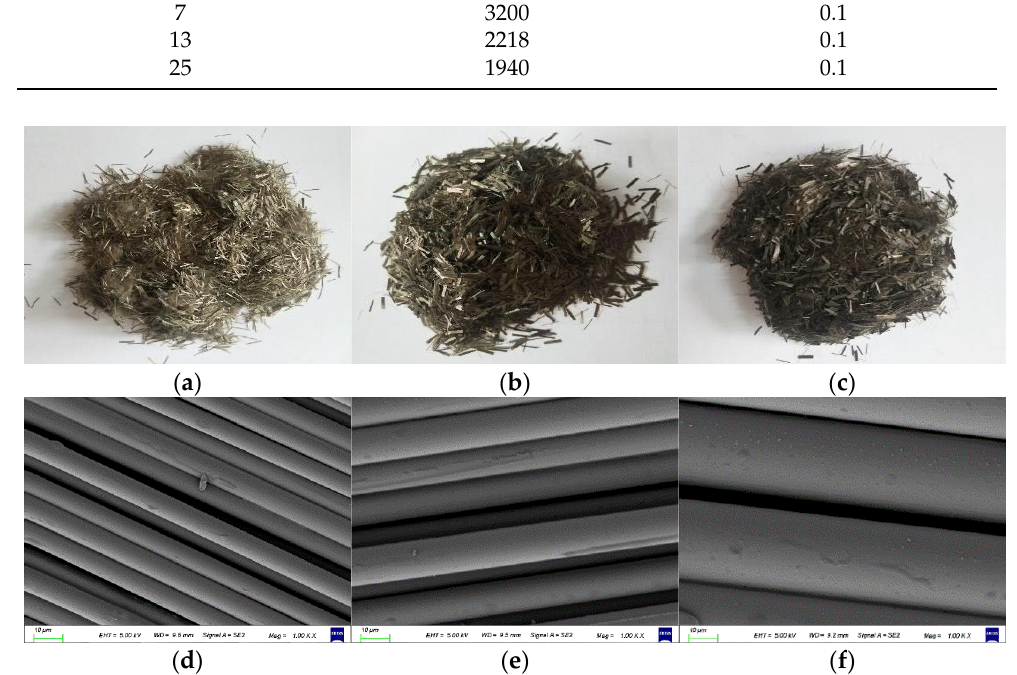
Figure 1. Macroscopic and microscopic morphologies of basalt fiber: ( a ) 7 µ m (macro picture); ( b ) 13 µ m (macro picture); ( c ) 25 µ m (macro picture); ( d ) 7 µ m (micro picture); ( e ) 13 µ m (micro picture); ( f ) 25 µ m (micro